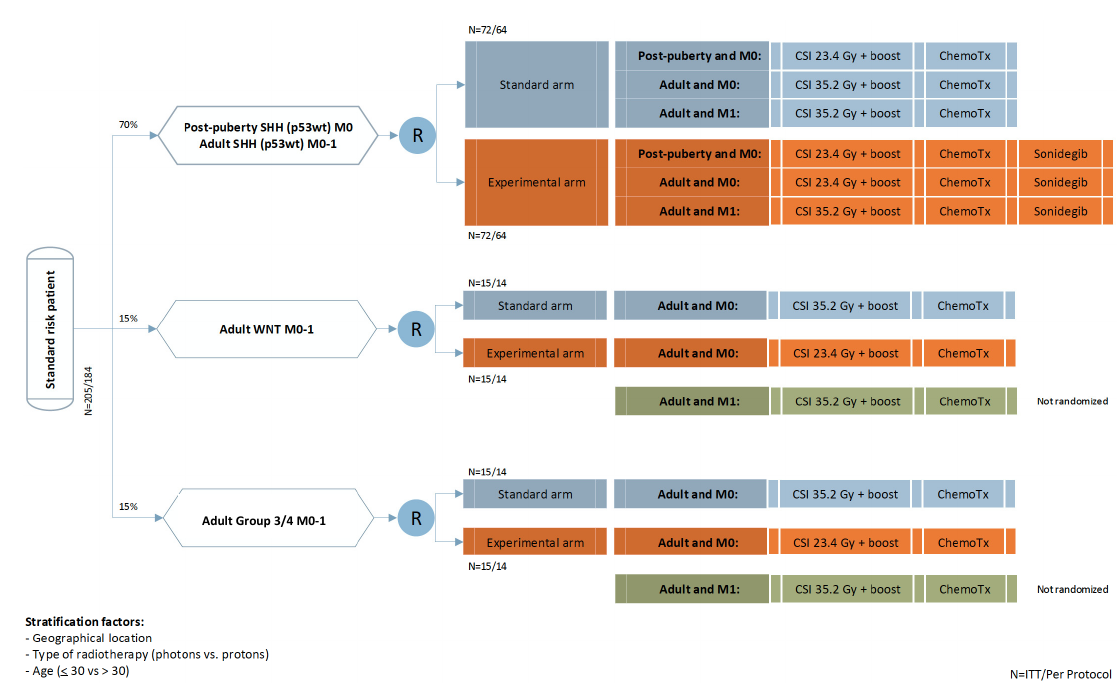
Figure 1. Trial design: Patients will be stratified into their respective genetic subgroups. Randomization will be performed into regular-dose (35.2 Gy) and low-dose (23.4 Gy) radiotherapy for all strata, and radio-chemotherapy vs. reduced radio-chemotherapy plus sonidegib in the SHH subgroup. Chemotherapy consists of 4 doses of vincristine 1.5 mg/m 2 (maximum 2 mg) during radiotherapy, followed by a maximum of 6 cycles of lomustine 75 mg/m 2 on day 1, cisplatin 70 mg/m 2 on day 1, and vincristine 1.5 mg/m 2 (max. 2 mg) on day 1 and 15 of 6-weekly cycles. The following modification for post-pubertal patients aged 17 and below with WNT and group 3/group 4 will apply: these patients will not be treated in the EORTC 1634-BTG/NOA-23 trial and will be recommended to participate in a suitable pediatric trial. N = number of pa- tients; R = randomization; SHH, WNT, group 3/group 4 are medulloblastoma subgroups; M = metastasis; CSI = craniospi- nal irradiation; Gy = gray; ChemoTx = chemotherapy, ITT = intent to treat. Please note that group 3 patients were not included in the initial version of the protocol, but will be included in the amended version 3.0 as depicted.